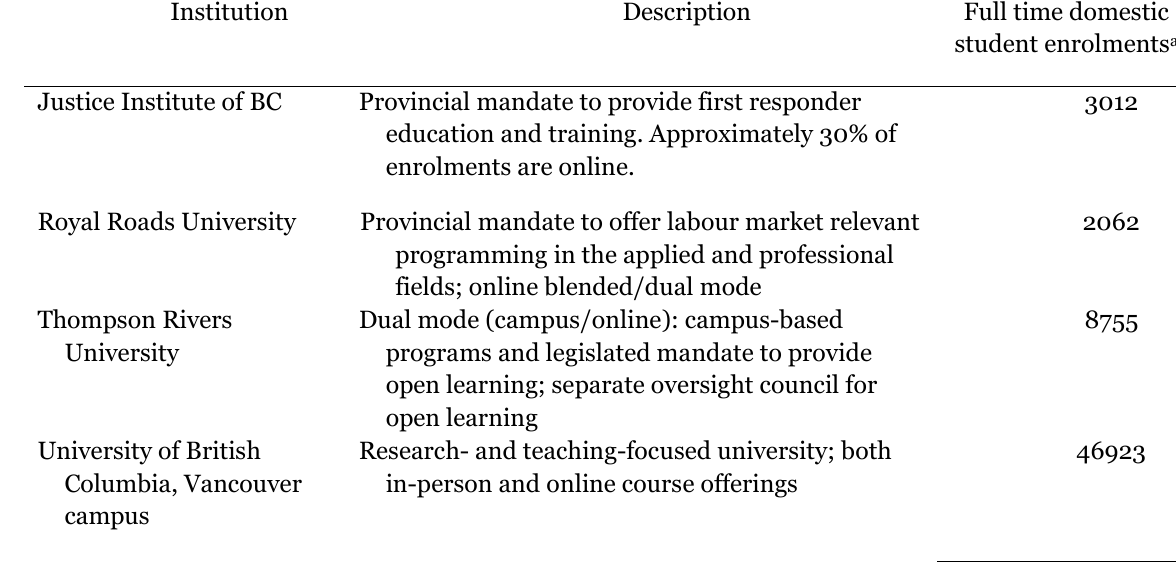
Characteristics of the Institutional